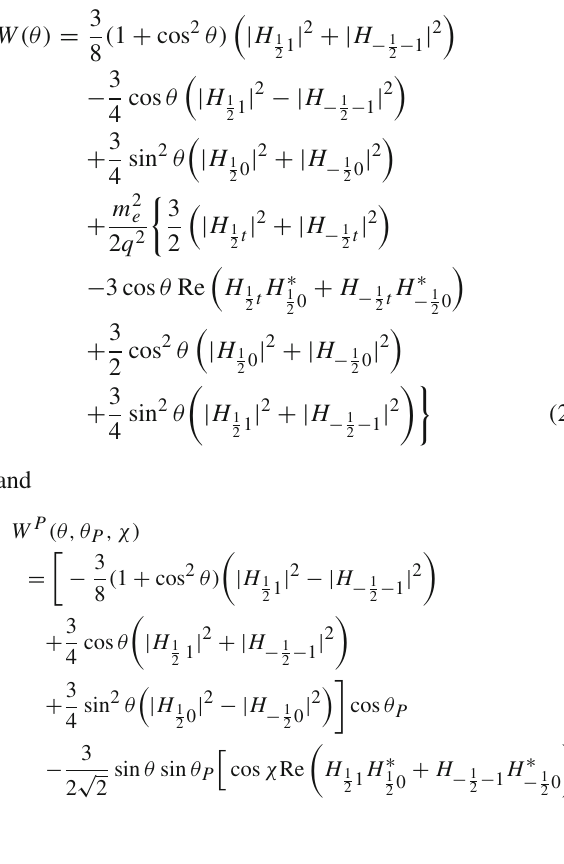
The momentum factor p denotes the magnitude of the three- momentum of the proton or of the W √ Q + Q − / 2 M n . p = and the (θ, θ P , χ) -dependent three-fold polarized angular decay distributions W P (θ, θ P , χ) can be calculated from Eq. (14). One